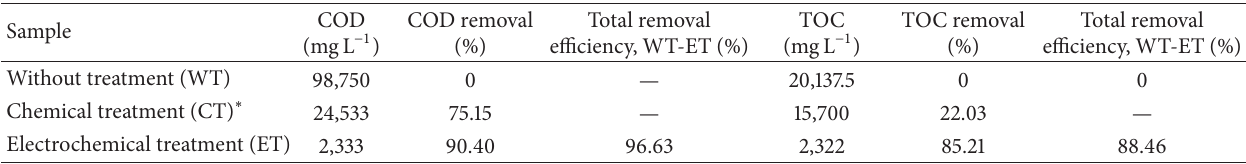
Table 3: Electrochemical treatment of spent caustics (mixture) using